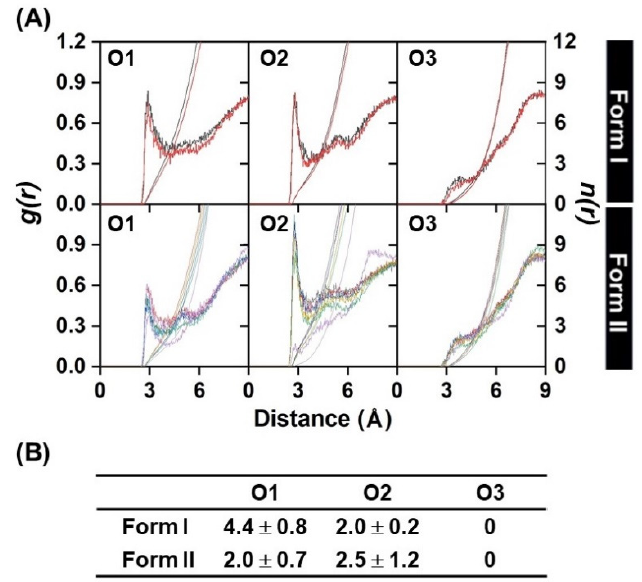
Figure 3. ( A ) Radial distribution function (RDF or g ( r )) of water oxygen atoms around the O1-O3 atoms of 3HF encapsulated in the γ -CD cavity over the last 50-ns MD simulations for Form I (MD3-MD4) and Form II (MD1-MD4 with initial structures in this form and additional MD1-MD2 from re-encapsulation process found in Form I). ( B ) Average integration number, n ( r ), up to the first minimum derived from RDF plots, corresponding to the number of water molecules pointing toward the focused oxygens of 3HF.